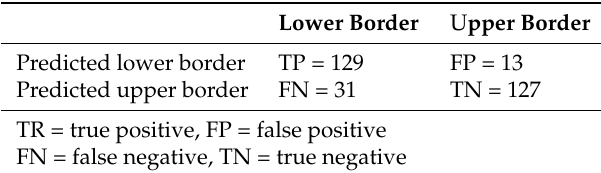
Table 7. Average confusion matrix, where five repetitions have been utilized with randomly selected data. Lower Border U pper